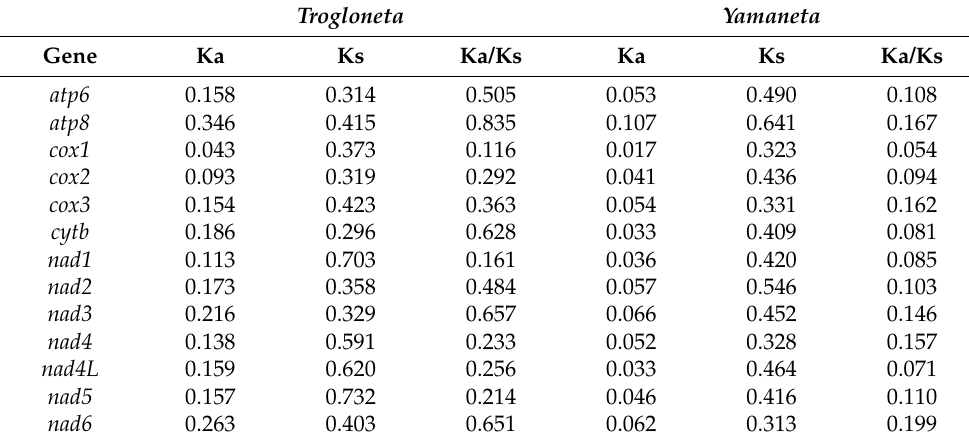
Table 5. Ka, Ks and Ka/Ks values for 13 PCGs of Trogloneta and Yamaneta